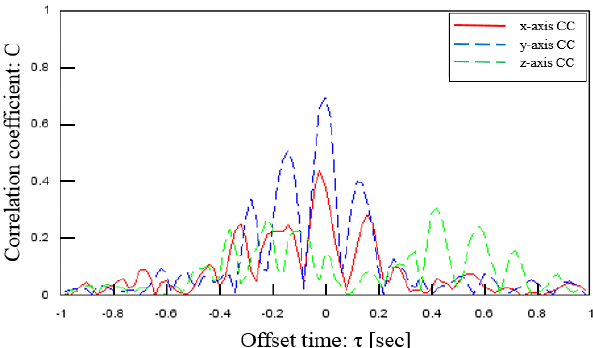
Figure 5: Correlation between true signal and signals from smartphone on the chest